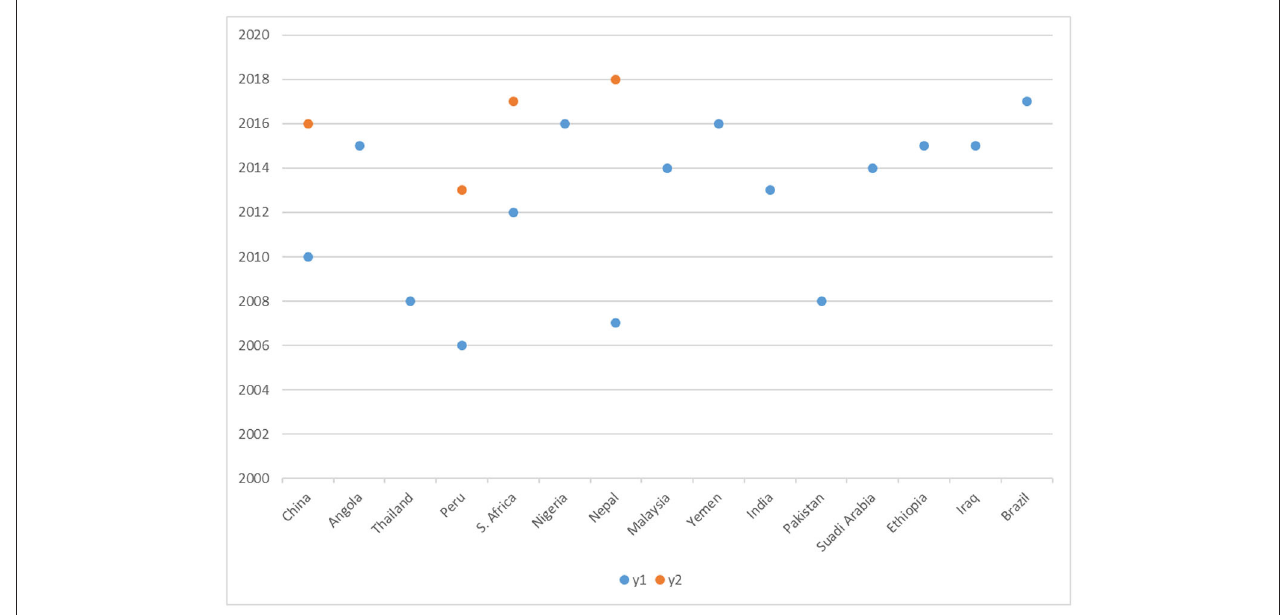
FIGURE 2 | Publications in different regions and in different periods.